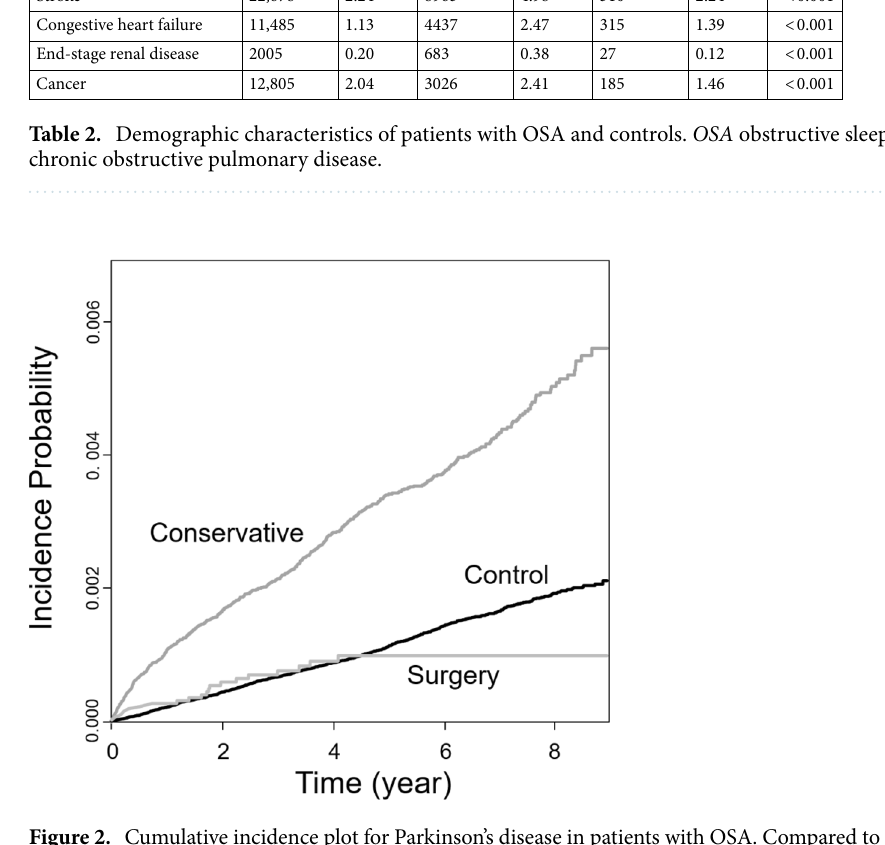
Figure 2. Cumulative incidence plot for Parkinson’s disease in patients with OSA. Compared to the Control group, Parkinson’s disease occurs more frequently in the Conservative group and less frequently in the Surgery group.